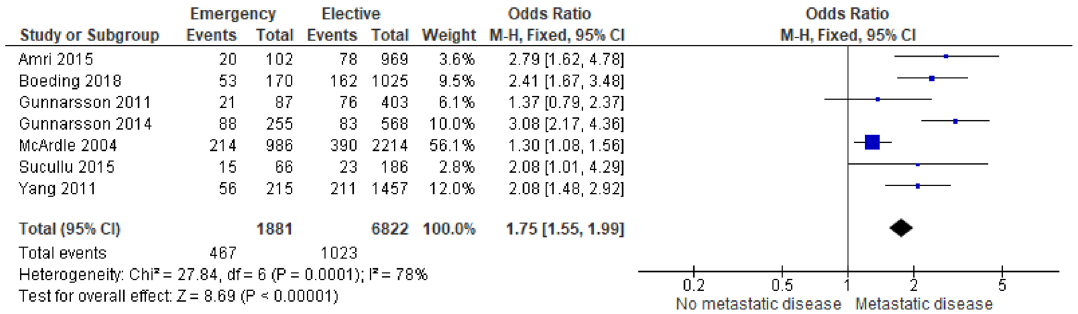
Figure 7. Association between M Stage and emergency presentation—Forest